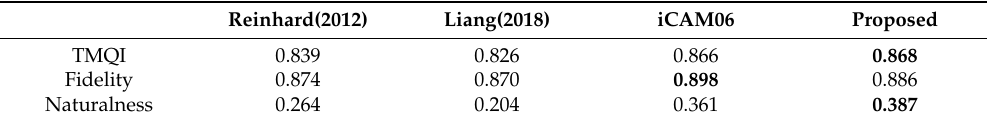
Table 2. Comparison with TMQI